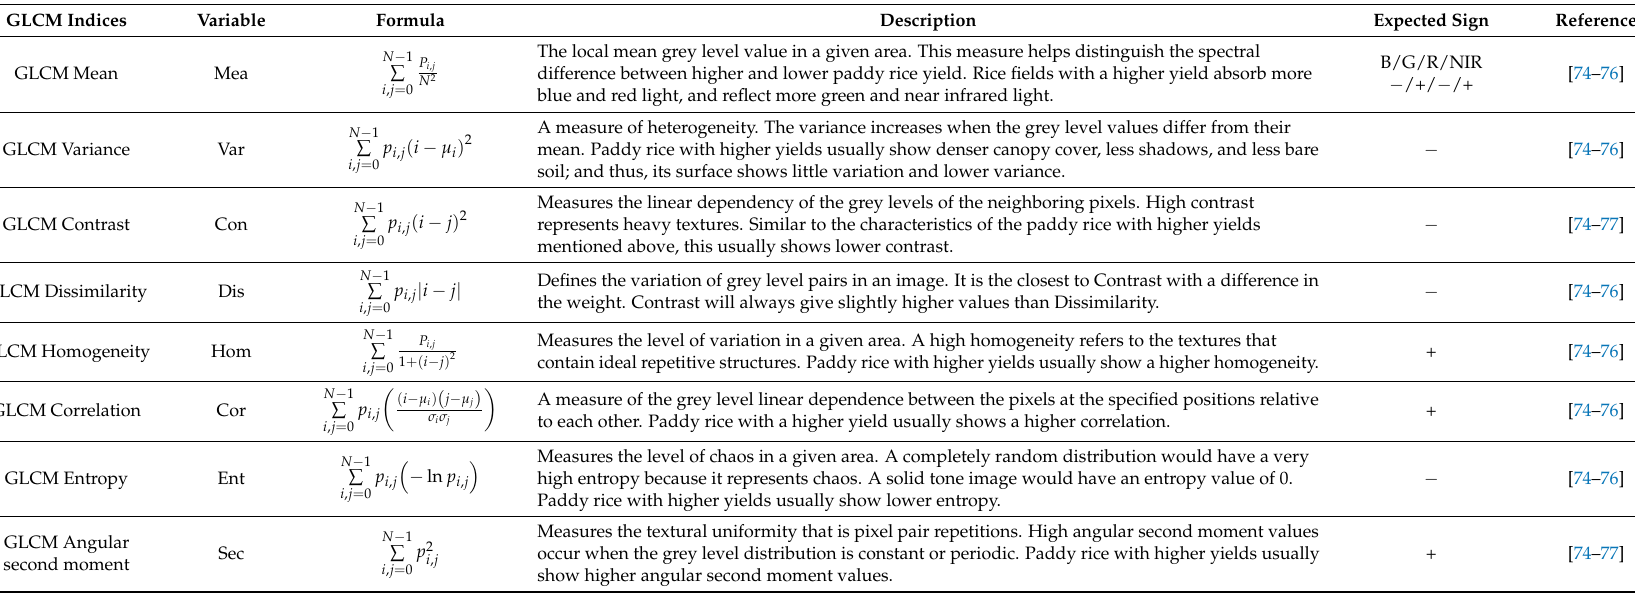
Table 2. Descriptions of the input grey-level co-occurrence matrix (GLCM) variables used for rice yield estimation. Description Expected Sign